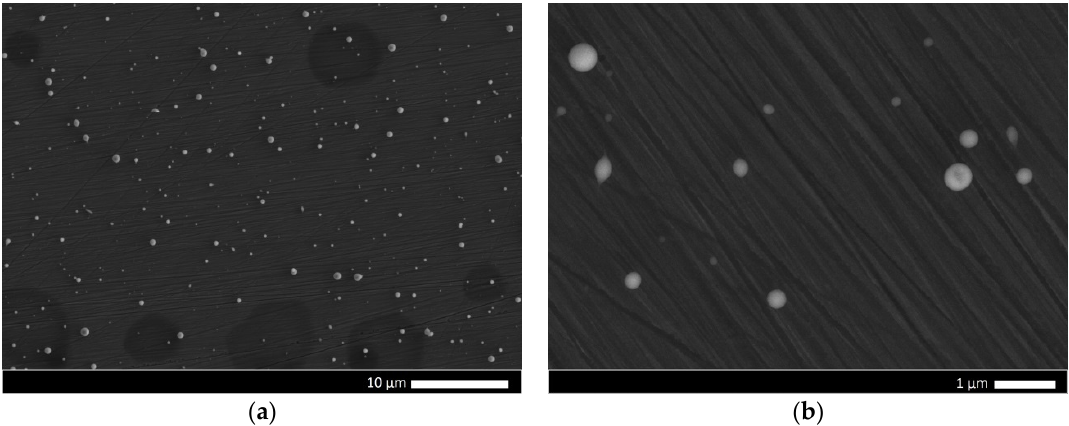
Figure 7. SEM photomicrographs of nanoparticles electrosprayed from the hyaluronic acid solutions with concentration 2.5 mg/mL under 30 kV: ( a ) magnification 4000×; ( b ) magnification 25,000×.